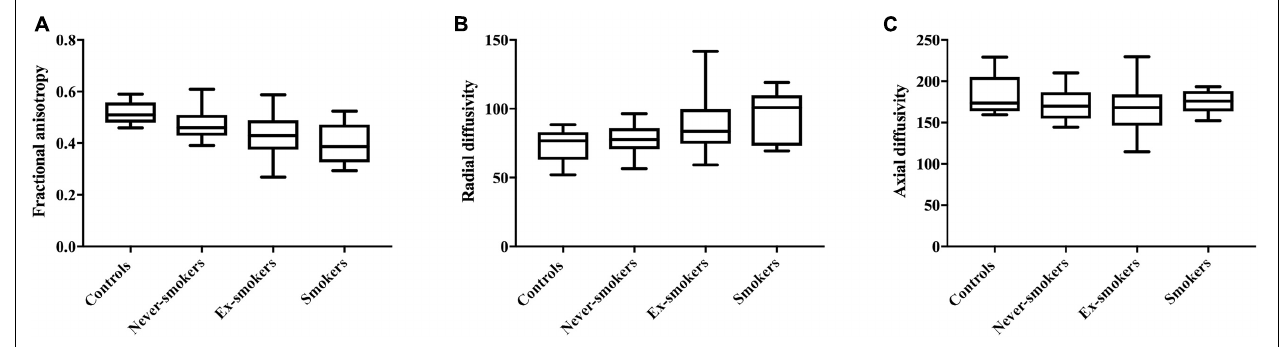
FIGURE 3 | Parameters derived from diffusion weighted MRN in all groups. (A) Fractional anisotropy in controls (0.52 ± 0.04), never-smokers (0.48 ± 0.06), ex-smokers (0.43 ± 0.09), and smokers (0.40 ± 0.08); F = 6.324: r 2 = 0.200; p < 0.001. (B) Radial diffusivity in controls (73.78 ± 11.94), never-smokers (77.71 ± 10.42), ex-smokers (88.33 ± 24.44), and smokers (93.53 ± 18.82); F = 4.264; r 2 = 0.147; p = 0.008. (C) Axial diffusivity in controls (182.80 ± 23.58), never-smokers (171.80 ± 19.41), ex-smokers (172.80 ± 30.86), and smokers (174.40 ± 14.05); F = 1.845; r 2 = 0.026; p = 0.570.